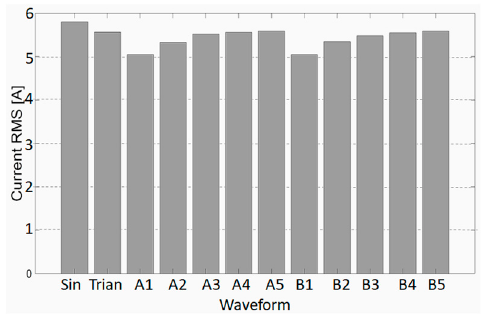
Figure 6. RMS values of load currents caused by the related voltage waveforms.